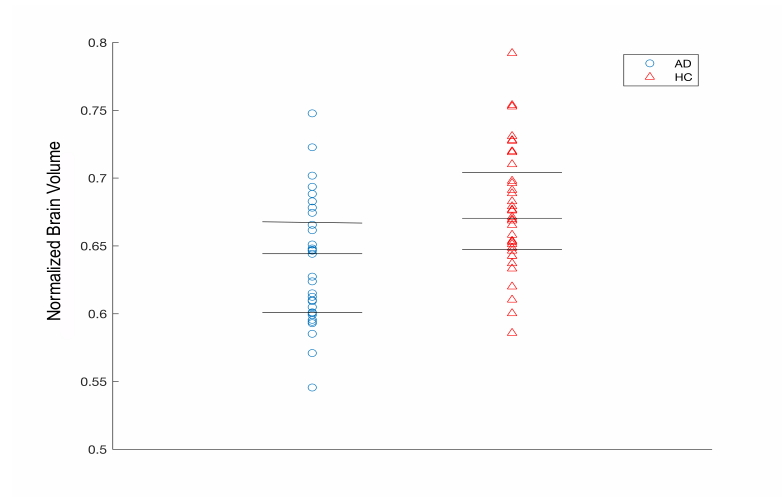
Figure 4. Statistical differences in normalized whole brain volume between HC and AD groups ( p <